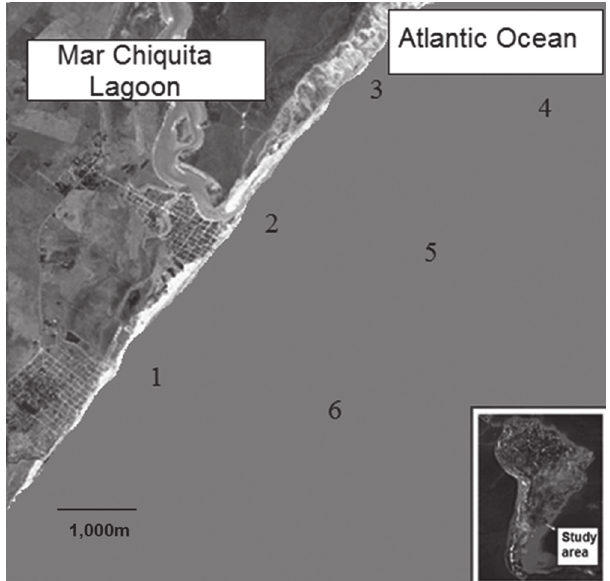
Fig. 1. Study area showing the sampling stations. Monthly abundance estimation. The abundance of